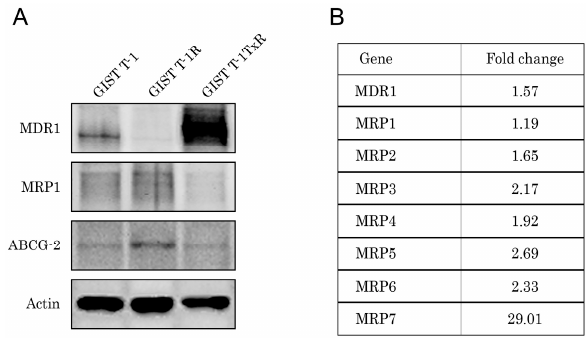
Figure 6. Multi-drug resistance (MDR) profile of GIST T-1R cells. ( A ) Expression of multi-drug resistance (MDR) proteins in GIST T-1 vs. GIST T-1R cells. Expression of P-glycoprotein (MDR-1) remained unchanged, whereas expression of ABCG2 and MRP-1 slightly increased in GIST T-1R cells when compared to parental GIST T-1 cells. The lysate of paclitaxel-resistant GIST T-1 cells (GIST-TxR) was used as a positive control for MDR-1 overexpression. Actin was used as a loading control; ( B ) Changes in the expression level of chemoresistance genes in GIST T-1R cells relative to GIST T-1 cells, as determined by reverse transcription quantitative polymerase chain reaction. GAPDH was amplified as an internal control.